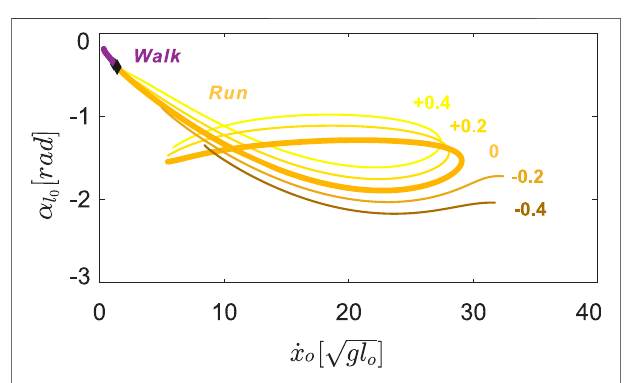
FIGURE 6 | Symmetrical gait structures for φ l (cid:2) φ r ∈ [− 0 . 4 , − 0 . 2 , 0 , + 0 . 2 , + 0 . 4 ] rad. Positive neutral leg swing angles retain the running branch shape and transition speed. Negative neutral leg swing angles shrink the running gait structure towards the mid-speed region, eliminating